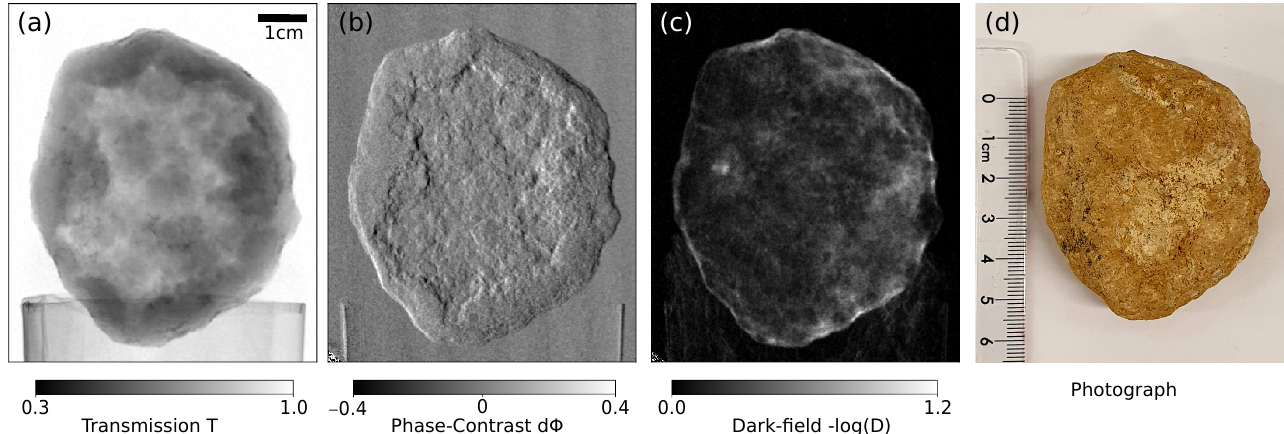
Figure 2. ( a – c ) One projection of the quartz geode in the three channels acquired at 1.6Å neutron wavelength. Attenuation image ( a ), differential phase-contrast image ( b ), dark-field image ( c ) and a photograph ( d